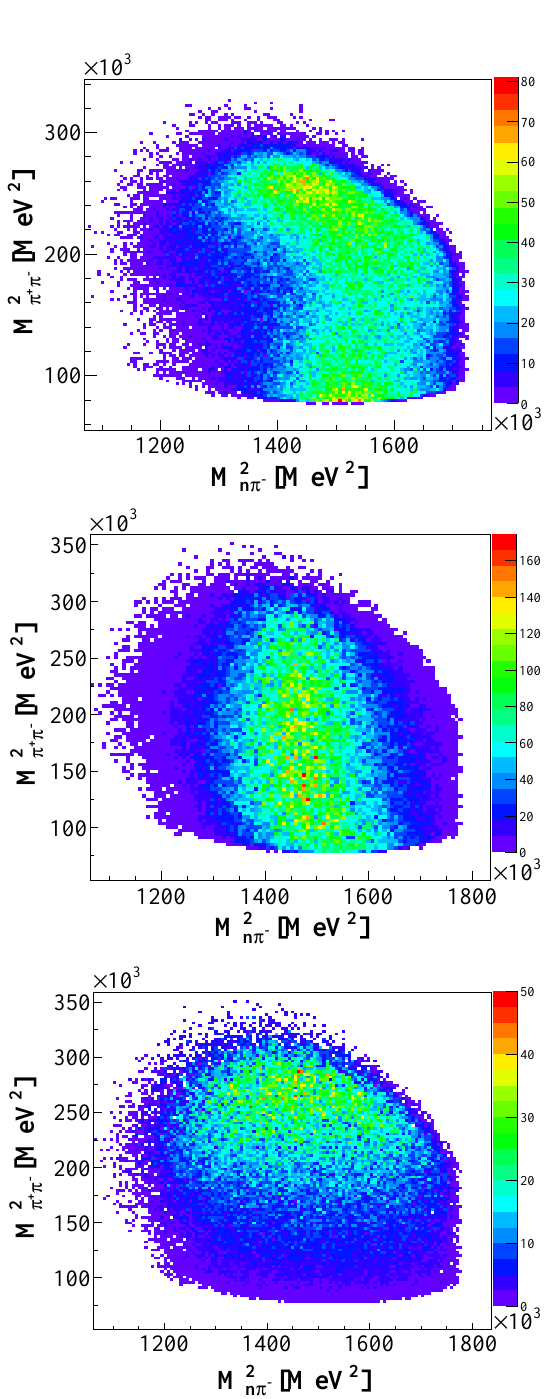
Figure 1. (Color online) Dalitz plots of π − p → n π + π − for data (top panel) and for the channels Δ π (middle panel) and N ρ (bot- tom panel) obtained from PWA at 0.654 GeV / c pion beam mo-